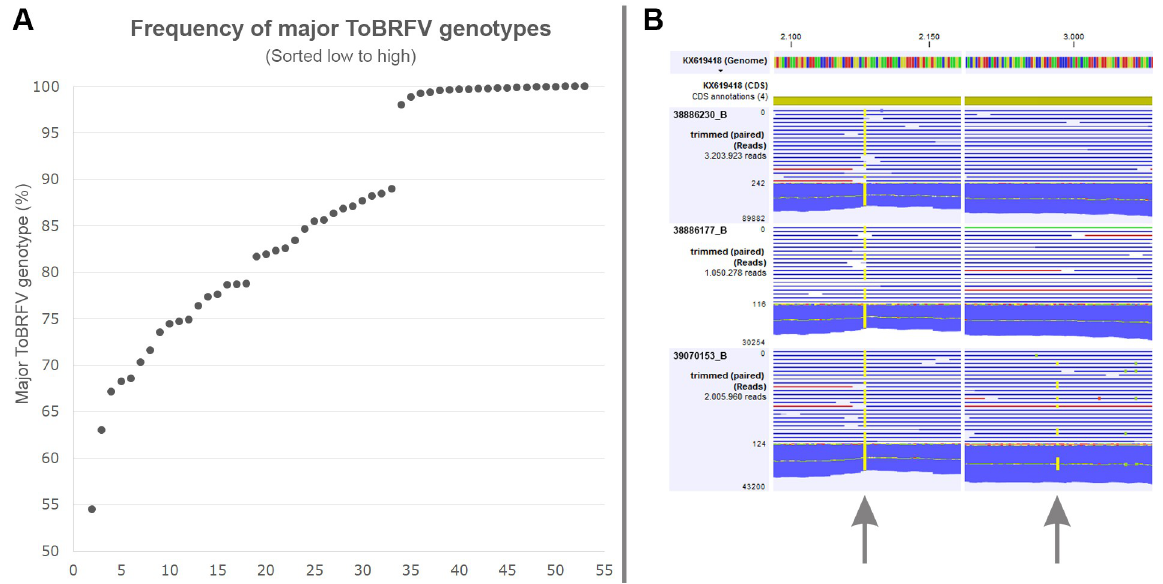
Fig 3. Within sample diversity of ToBRFV genotypes. A . Frequency (y-axis) of major ToBRFV genotypes in datasets (x-axis) generated in this study. Within sample frequencies of major genotypes are sorted low to high. B . Detail of RNAseq read mappings to the small replicase subunit of KX619418 for ToBRFV samples 38886230_B, 38886177_B, and 39070153_B. For each sample the total number of mapped reads is shown as well as the maximum read coverage. The left SNP (arrow) represents a single genotype ( > 99.7%) that is present in all three samples. The right SNP reveals the presence of a minor genotype (32.8%) in sample